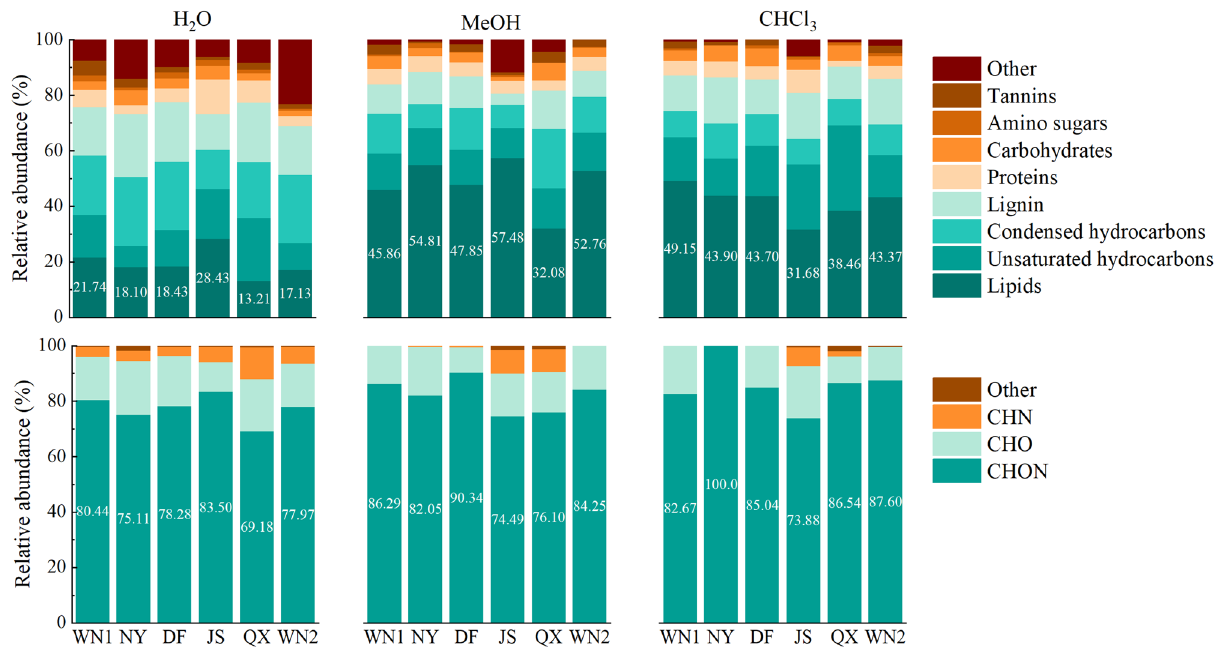
Figure 5. The relative abundances of SOM compounds sequentially extracted by H 2 O, MeOH, and CHCl 3 determined by